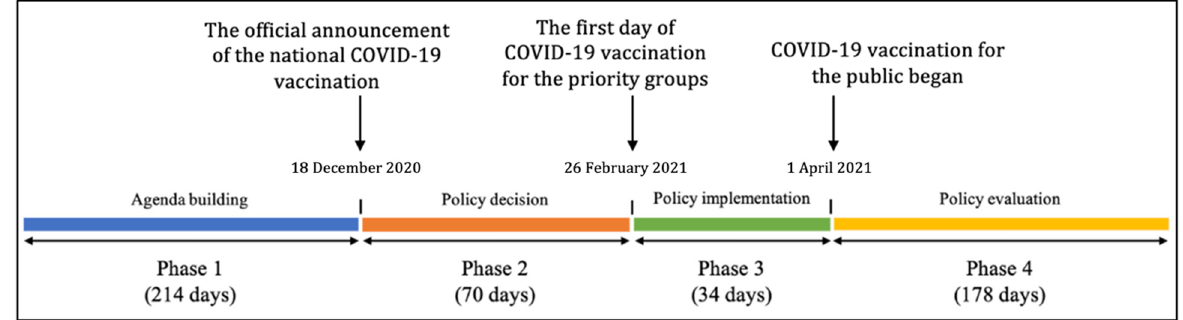
Figure 1. COVID-19 phases in the study period.